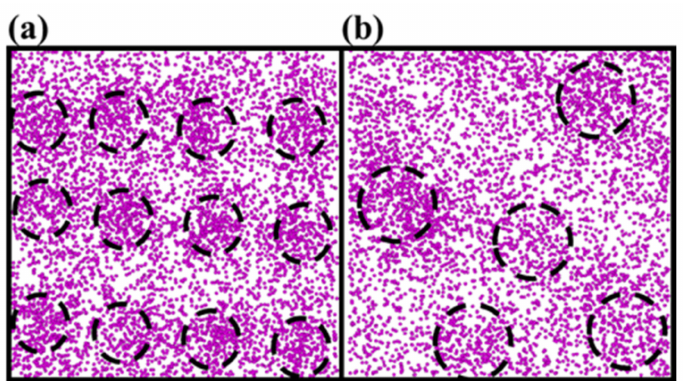
Figure 7. 18 × 18 × 2 nm 3 slice showing distribution of fission products observed from APT data in ( a ) M11 and ( b ) M14 samples, respectively. Dotted circles are used to highlight enriched segregation of fission products. Table 2. Measured composition from M11 and M14 samples using APT (impurities: C, N, Si, and O). M11 M14 Elements at.% 2Sigma at.% 2Sigma U 74.22 0.59 65.6 0.64 Mo 19.80 0.53 26.8 0.36 Fission Products 5.66 0.30